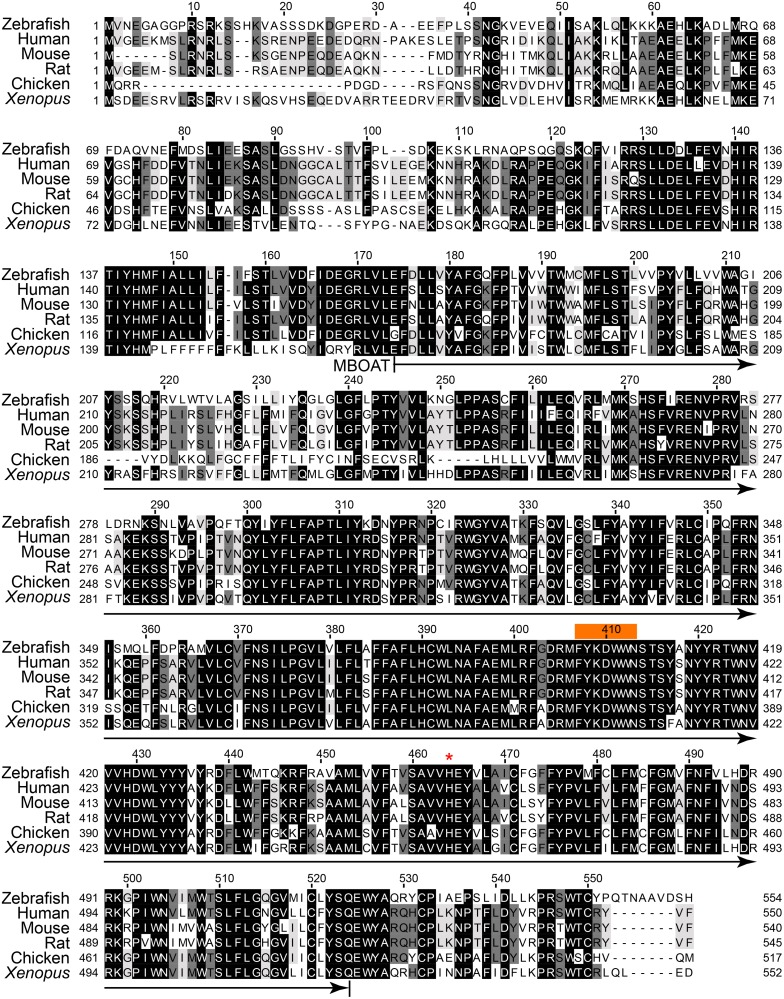
Sequence similarity of Soat1 among various animal species.Zebrafish Soat1 amino acid sequences are aligned with the SOAT1 orthologs from human (ENSP00000356591), rat (ENSRNOP00000005677), mouse (ENSMUSP00000058344), chicken (ENSGALP00000006691) and Xenopus (ENSXETP00000050224). The amino acid sequence of zebrafish Soat1 was predicted according to the cloned sequence. The MBOAT domain is predicted between 168 to 517 residue (arrow under sequences). The acyl-CoA binding domain (FYXDWWN, orange box above the sequences) and the postulated catalytical residue for esterification (His457, red asterike above the sequences) are conservative through species. The identical amino acids are shown in the black box, while the less conservative regions are enclosed by white box.